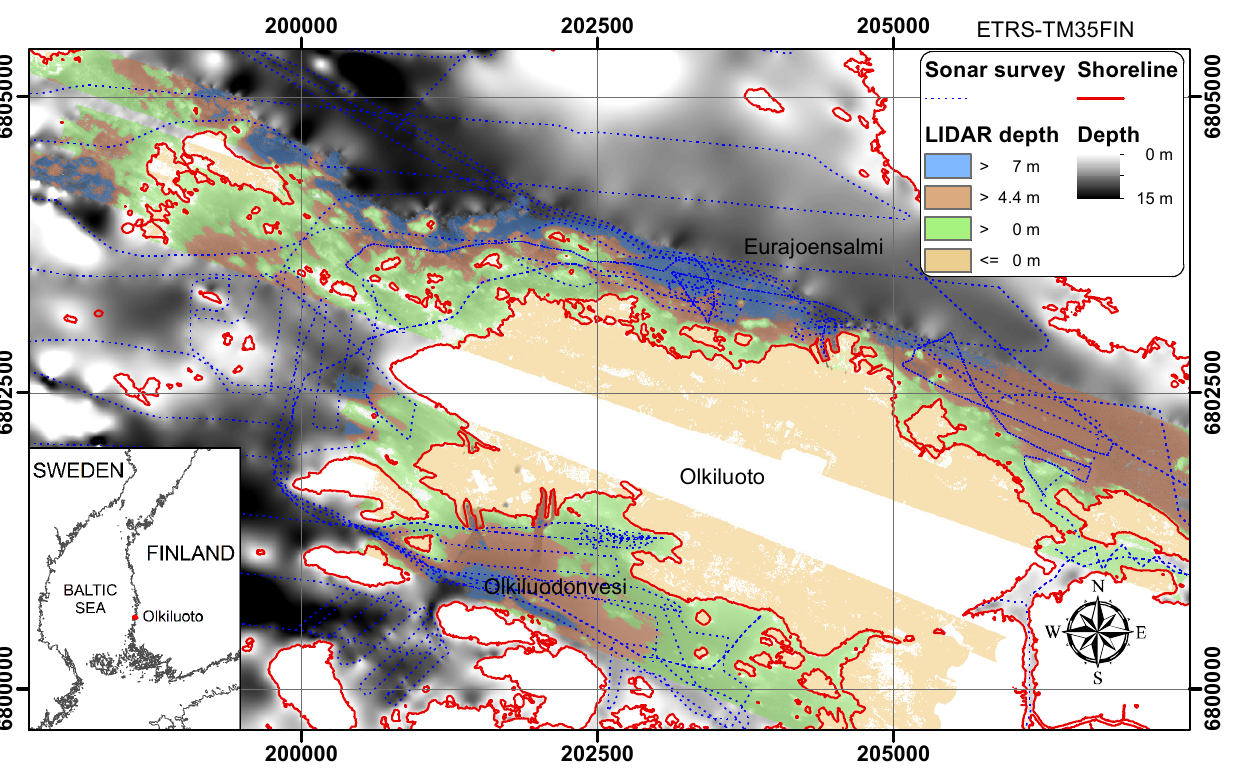
Figure 1. Survey areas: the gray-scale and color-coded rasters represent seabed elevation interpolated from the sonar and bathymetric LiDAR measurements. The LiDAR survey areas are highlighted in color. The sonar survey lines are also indicated in the figure. The LiDAR return pulse waveform contains also information on benthic vegetation. The